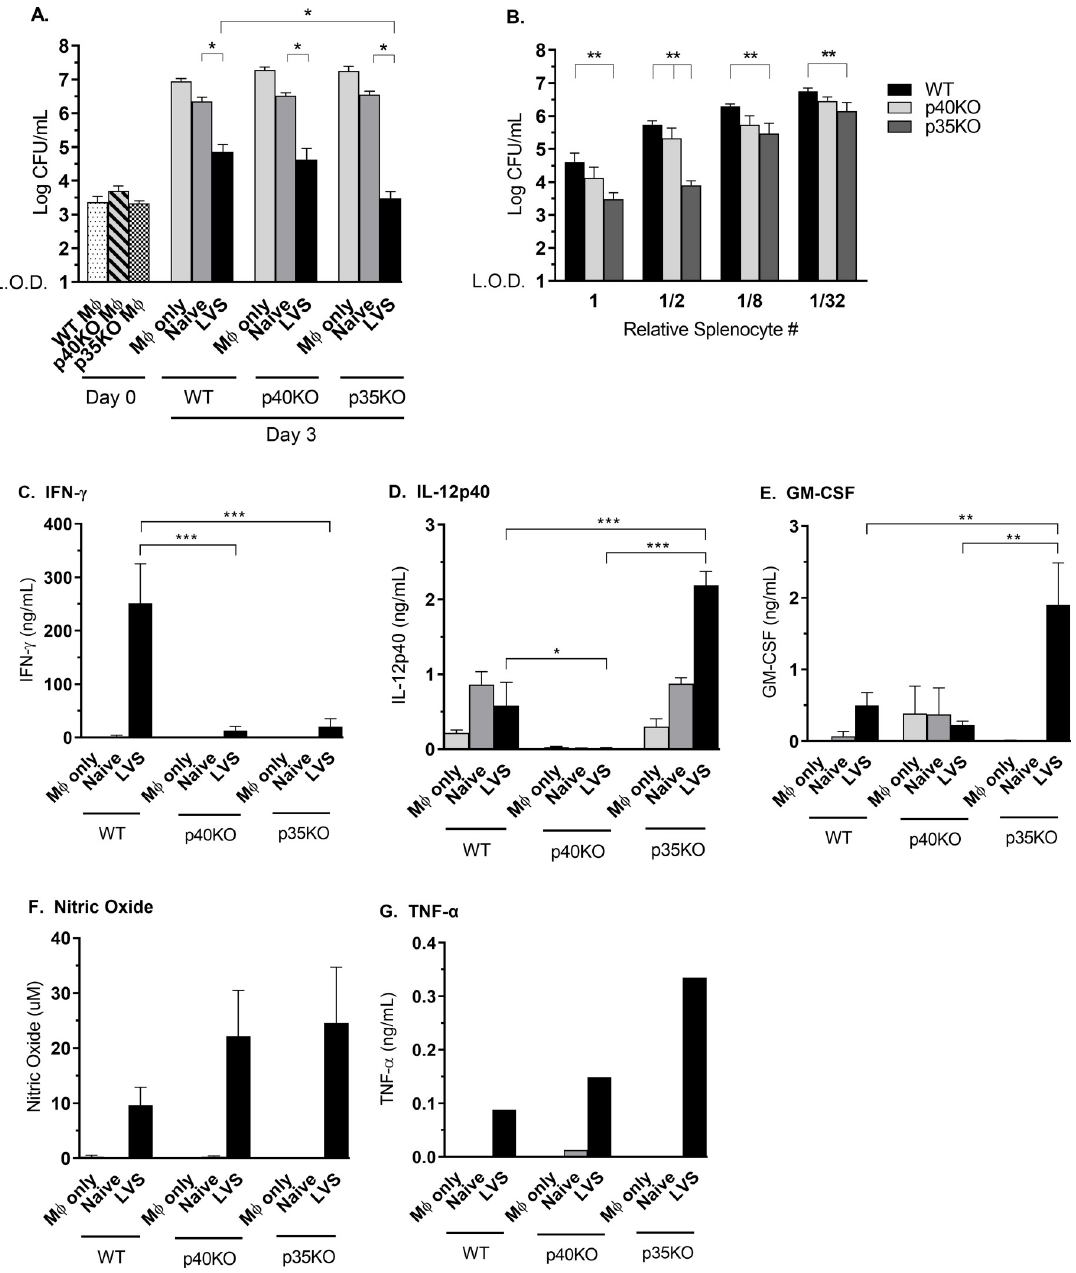
Fig 2. IL-12p40 KO splenocytes control intramacrophage LVS replication. Splenocytes from 5 na ï ve mice or 5 mice vaccinated with 10 5 LVS i.d. were co-cultured with LVS-infected BMDMs from the same genotype. Bacterial CFU were assessed immediately after infection (Day 0) and three days after infection (A). Decreasing numbers of splenocytes were added to a constant number of infected BMDMs, where 1 = 5 x 10 6 splenocytes. Intramacrophage bacterial growth was assessed three days after infection (B). Supernatants pooled from three wells per group were collected on day 3 after infection from the experiment illustrated in (A) for analyses of IFN- γ (C), IL-12p40 (D), GM-CSF (E), nitric oxide (F), and TNF- α (G). Data shown are averages of three independent experiments (A–F) or one experiment (G). Mice used were ages 3–9 months and were aged matched within each experiment. � p < 0.05; �� p < 0.01; ��� p < 0.001 by ANOVA with Tukey’s multiple comparisons test.